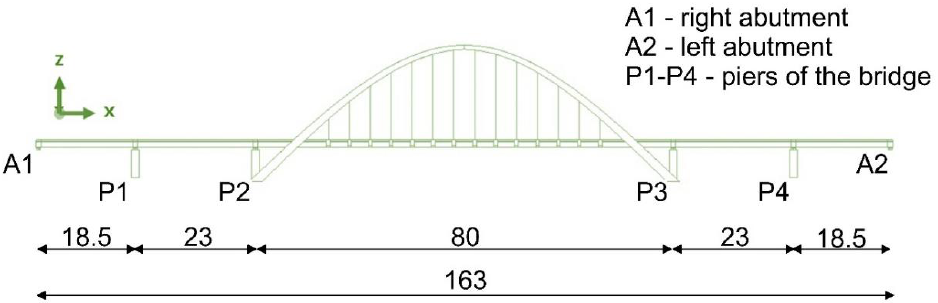
Figure 3. The side view of the bridge with main dimensions [m].